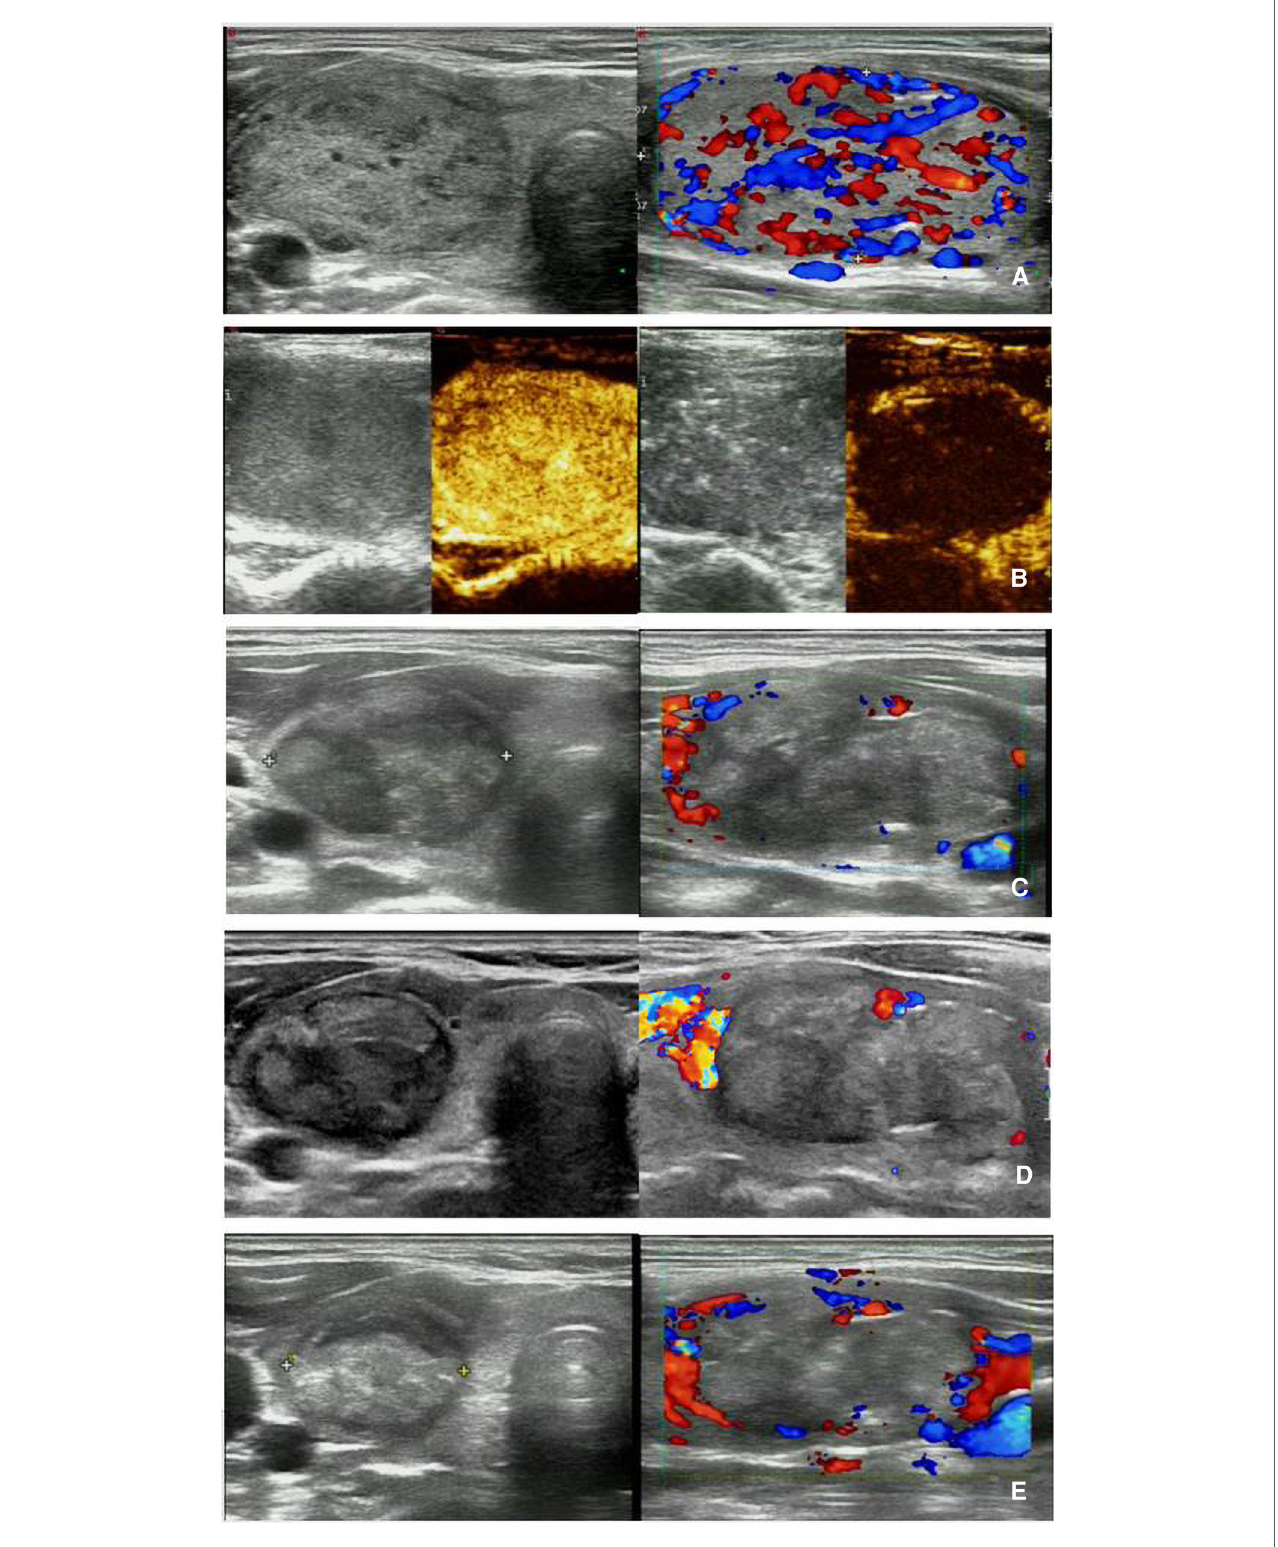
FIGURE 4 MWA-treated BTN with HT in a 37-year-old woman. ( A ) Pre-MWA transverse grayscale ultrasound (left) and longitudinal CDFI (right) demonstrate a nodule with regular shape and clear margin, abundant blood fl ow, size of 48×31×33 mm, volume of approximately 17.93 ml, and pathologically con fi rmed as BTN by needle biopsy; ( B ) Pre-MWA CEUS (left) shows the nodule with uniform hyperenhancement, and post-MWA CEUS (right) shows the nodule without enhancement; C-E. Post-MWA at 1 month ( C ), 3 months ( D ), and 6 ( E ) months after MWA; transverse grayscale ultrasound (left) and longitudinal CDFI (right) shows that the nodules gradually decreased size, with sizes of 40×26×20 mm, 34×22×18 mm, and 32×18×16 mm, respectively, volumes of approximately 10.90 ml, 7.06 ml, and 4.83 ml, respectively, and VRR of 39.21%, 60.62%, and 73.06% respectively. MWA, microwave ablation; BTN, benign thyroid nodule; HT, Hashimoto ’ s thyroiditis; VRR, volume reduction ratio; CDFI, Color Doppler Flow Imaging; CEUS, contrast-enhanced